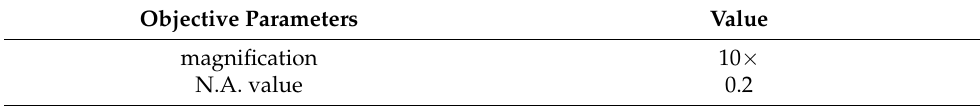
Figure 9. Diagram of the chromatic confocal system with inclined illumination. Table 1. The parameters of the